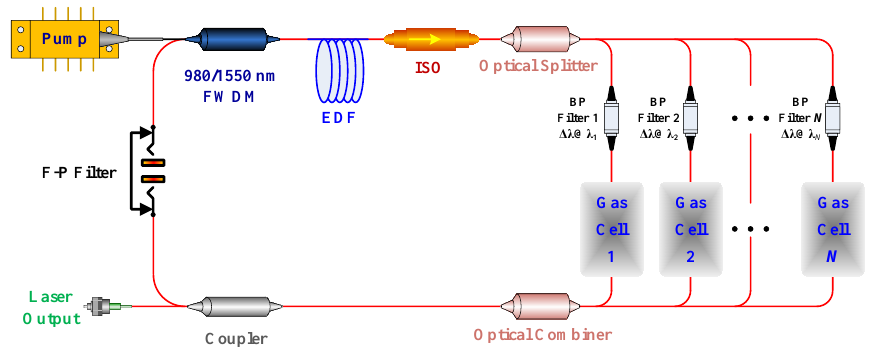
Figure 1. Schematic principle of the sensing system. EDF, Er-doped fiber; ISO, isolator; FWDM, filter wavelength division multiplexing; F–P, Fabry–Perot; BP, band-pass.